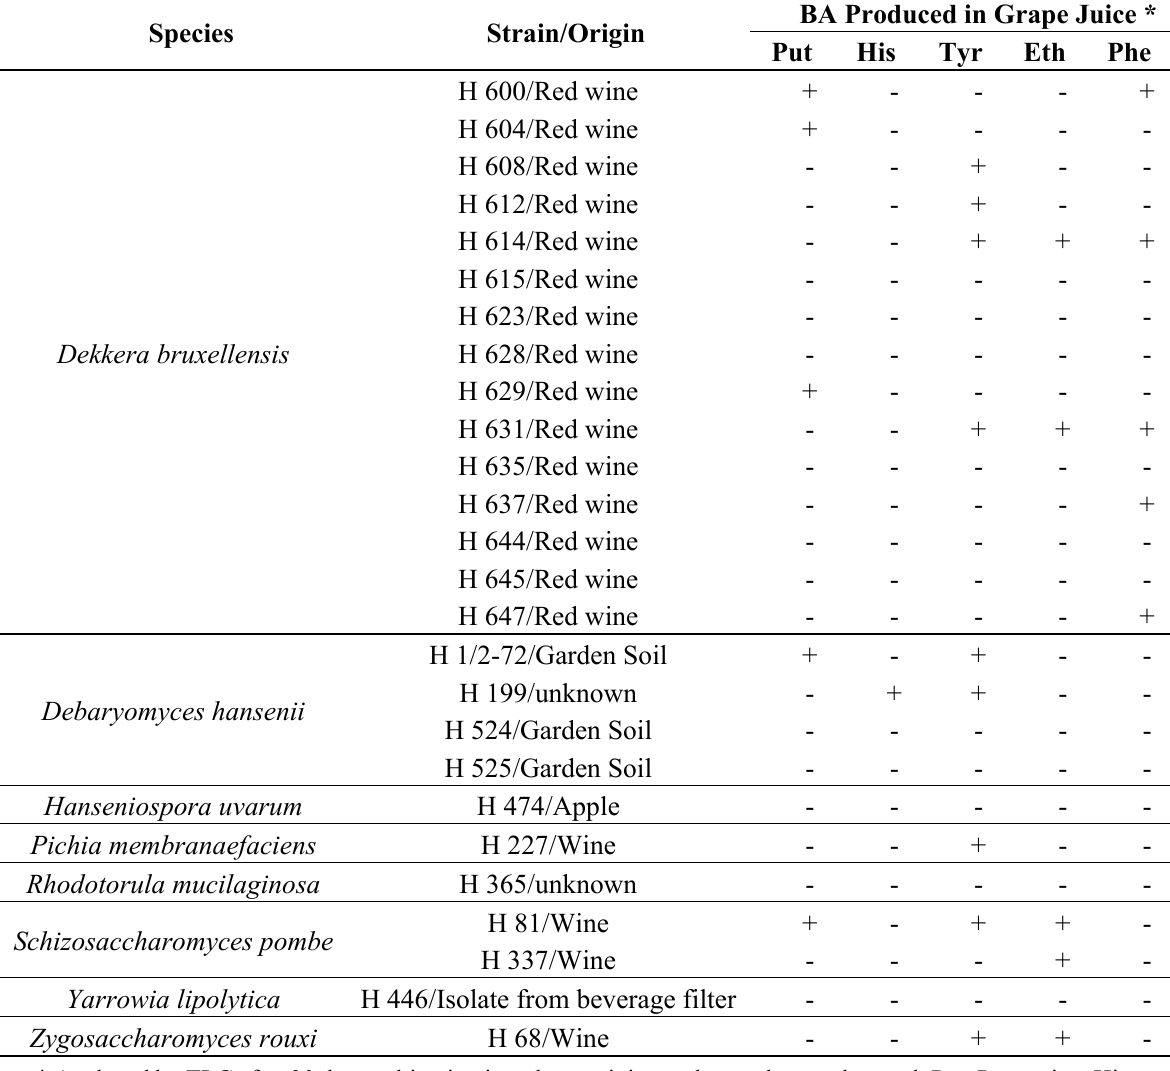
Table 1. Production of BA in grape juice by the yeast strains investigated.